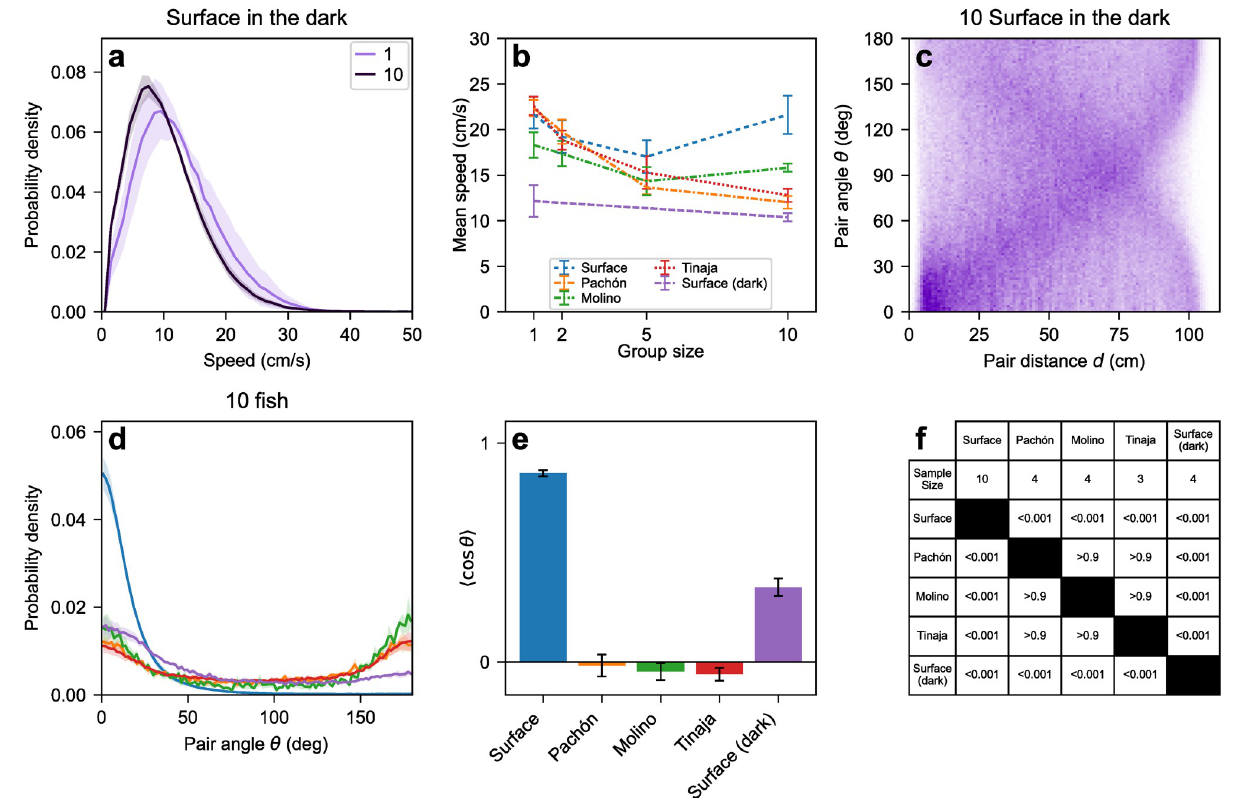
Fig 6. (a) Speed distributions of surface fish in the dark in groups of 1 and 10. The halo around each curve corresponds to one standard error on either side of the mean. (b) Mean speed vs group size for all populations in the light and surface fish in the dark. Surface fish swim slower in the dark than in the light, but their mean speed in the dark shows little change as a function of group size. Linear regression slope m SuDark = − 0.2 ± 0.2 ( N = 7, p = 0.303). See Fig 3 for the slopes of surface fish in the light, Pacho´n, Molino, and Tinaja, plotted here again for comparison. (c) The probability density of relative distance and angle exhibits both a spread over the entire tank and a low peak at small distance and angle, indicating locally coordinated swimming but no fully formed school. (d) Probability density of the pair angle θ when the two fish are near each other (within 10 cm). The halo around each curve corresponds to one standard error on either side of the mean. (e) Average of cos θ , which measures whether pairs of fish tend to move in the same direction ( h cos θ i > 0) or in opposite directions ( h cos θ i < 0). (f) Statistics of h cos θ i . Surface fish in the dark are significantly less likely to be aligned than surface fish in the light, but significantly more likely to be aligned than any cave population. N SuLight = 10, N Pa = 4, N Mo = 4, N Ti = 3, N SuDark = 4. One-way ANOVA: p < 0.001. Tukey HSD adjusted p-values: p Su-SuDark < 0.001, p Su-Pa < 0.001, p Su-Mo < 0.001, p SuDark-Pa < 0.001, p SuDark-Mo < 0.001, p SuDark-Ti < 0.001, p Pa-Mo > 0.9, p Pa-Ti > 0.9, p Mo-Ti >